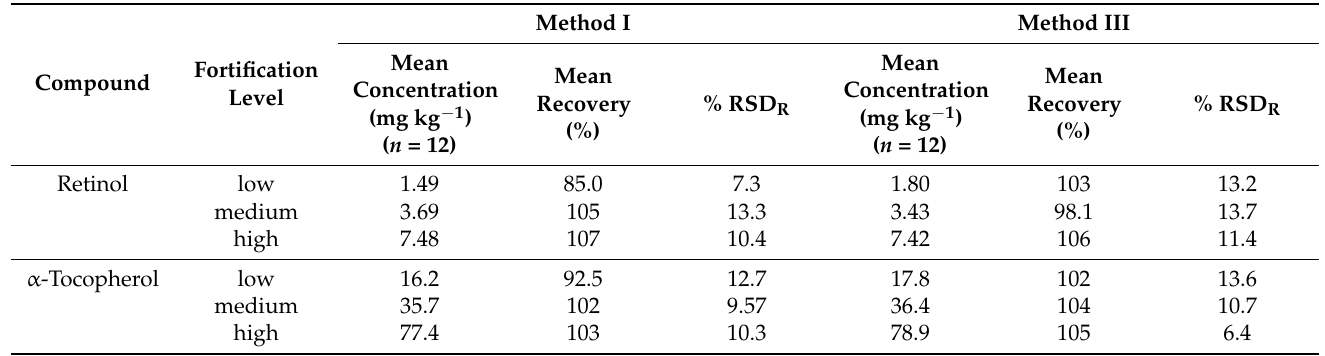
Table 5. Comparative results of recoveries and precision for Vitamins A and E.